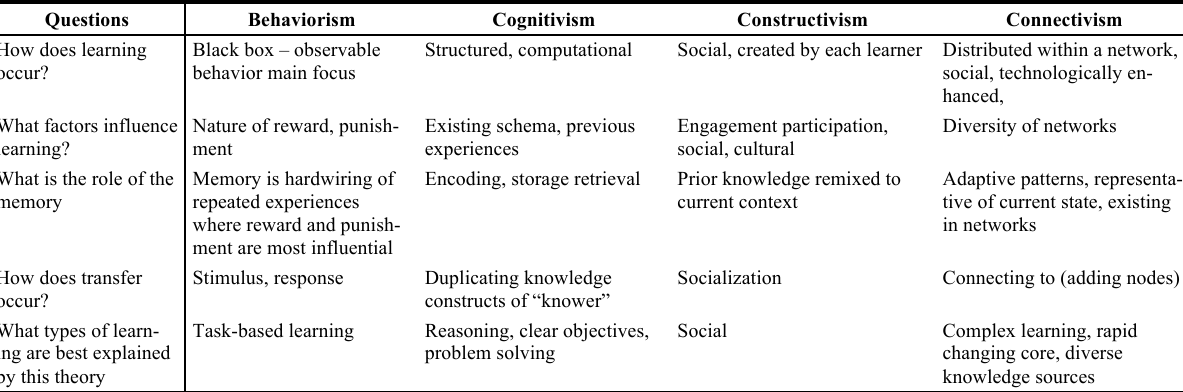
TABLE I. A COMPARISON BETWEEN THE DIFFERENT PEDAGOGIES